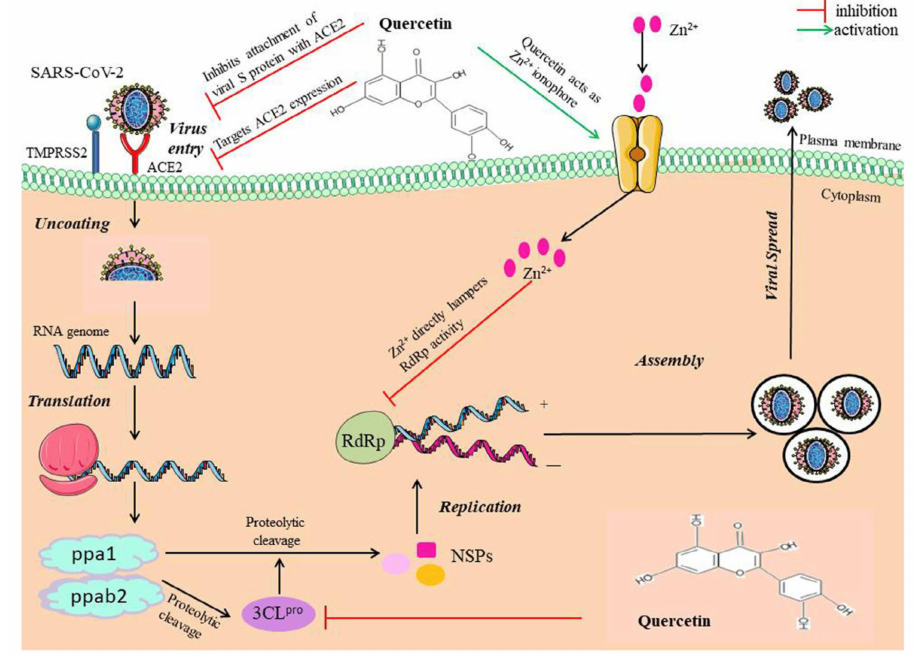
Figure 5. Various mechanisms via which quercetin neutralizes SARS-CoV-2 virus. Reproduced from reference [170] with